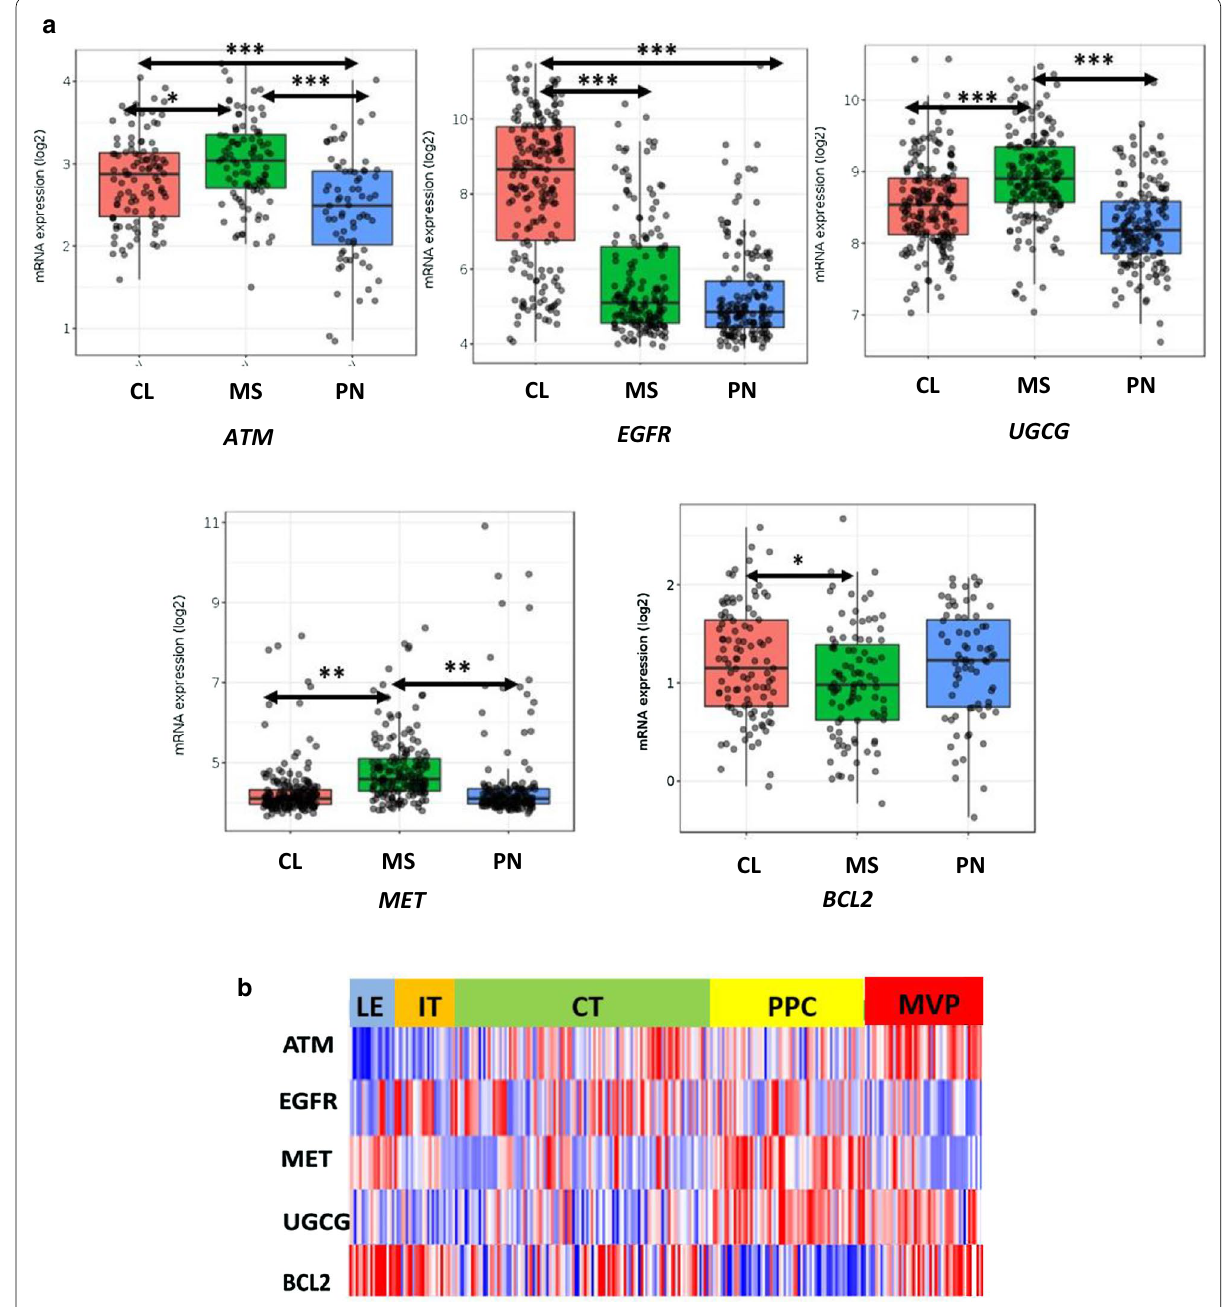
Fig. 5 Significant heterogeneity exists in the expression of resistance mechanisms in glioblastoma. a Expression of resistance genes in different glioblastoma subtypes. Log2 mRNA expression of resistance genes in classical (orange), mesenchymal (green) and proneural (blue) subtypes. Tukey HSD test was used to assess statistical significance. ***p < 0.001; **p < 0.01; *p < 0.05. Horizontal lines refer to the groups being compared for statistical analysis. CL: classical glioblastoma subtype, MS: mesenchymal glioblastoma subtype, PN: proneural glioblastoma subtype. b